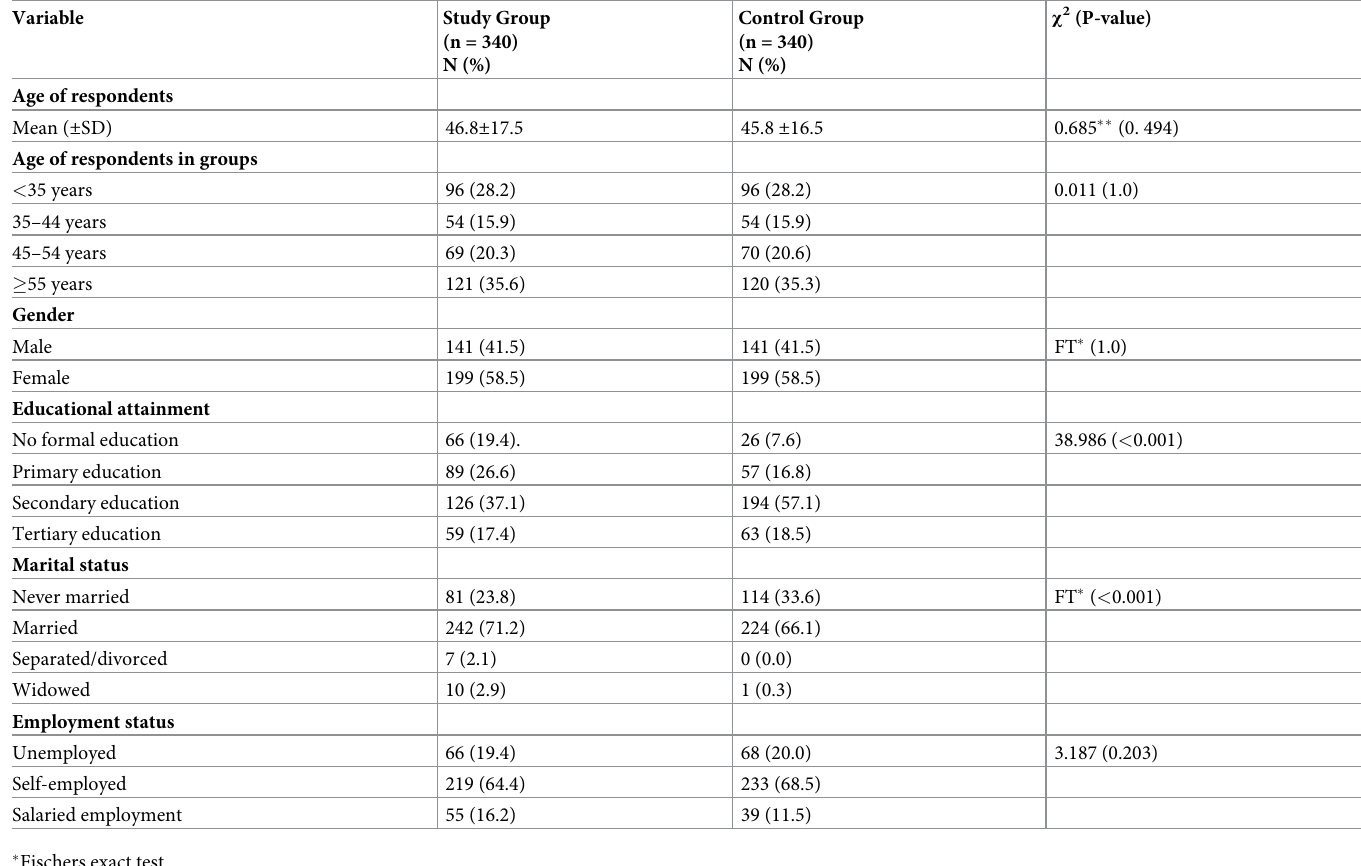
Table 1. Socio-demographic characteristics of the